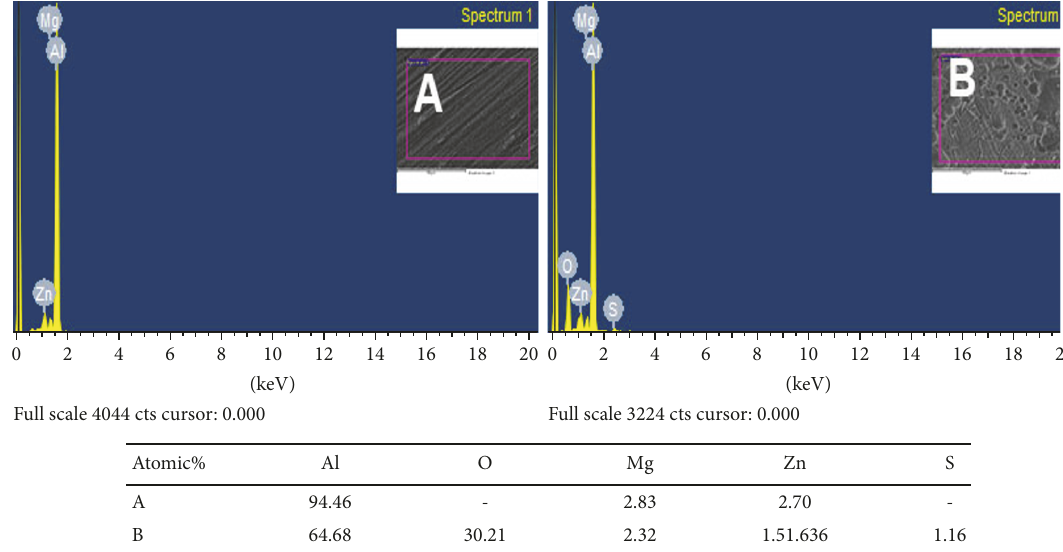
Figure 14: EDS results of Al 7075 “A” before and “B” after being immersed in the Red Sea water for 5 weeks.